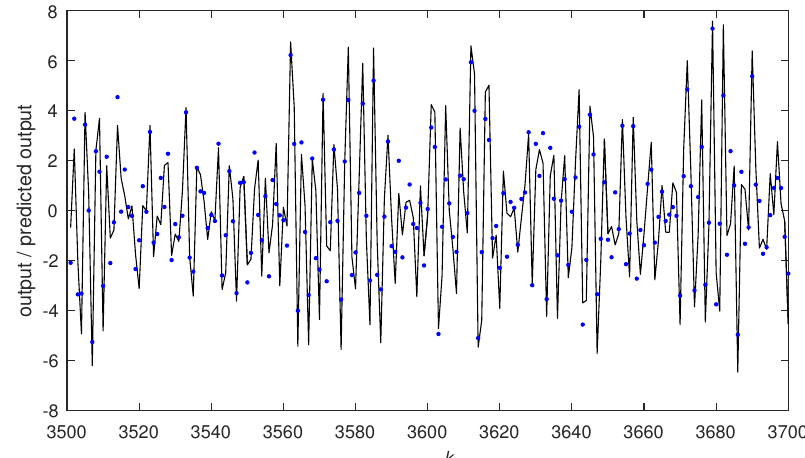
Figure 6. The predicted output ˆ y k and true output y k from k = 3501 to